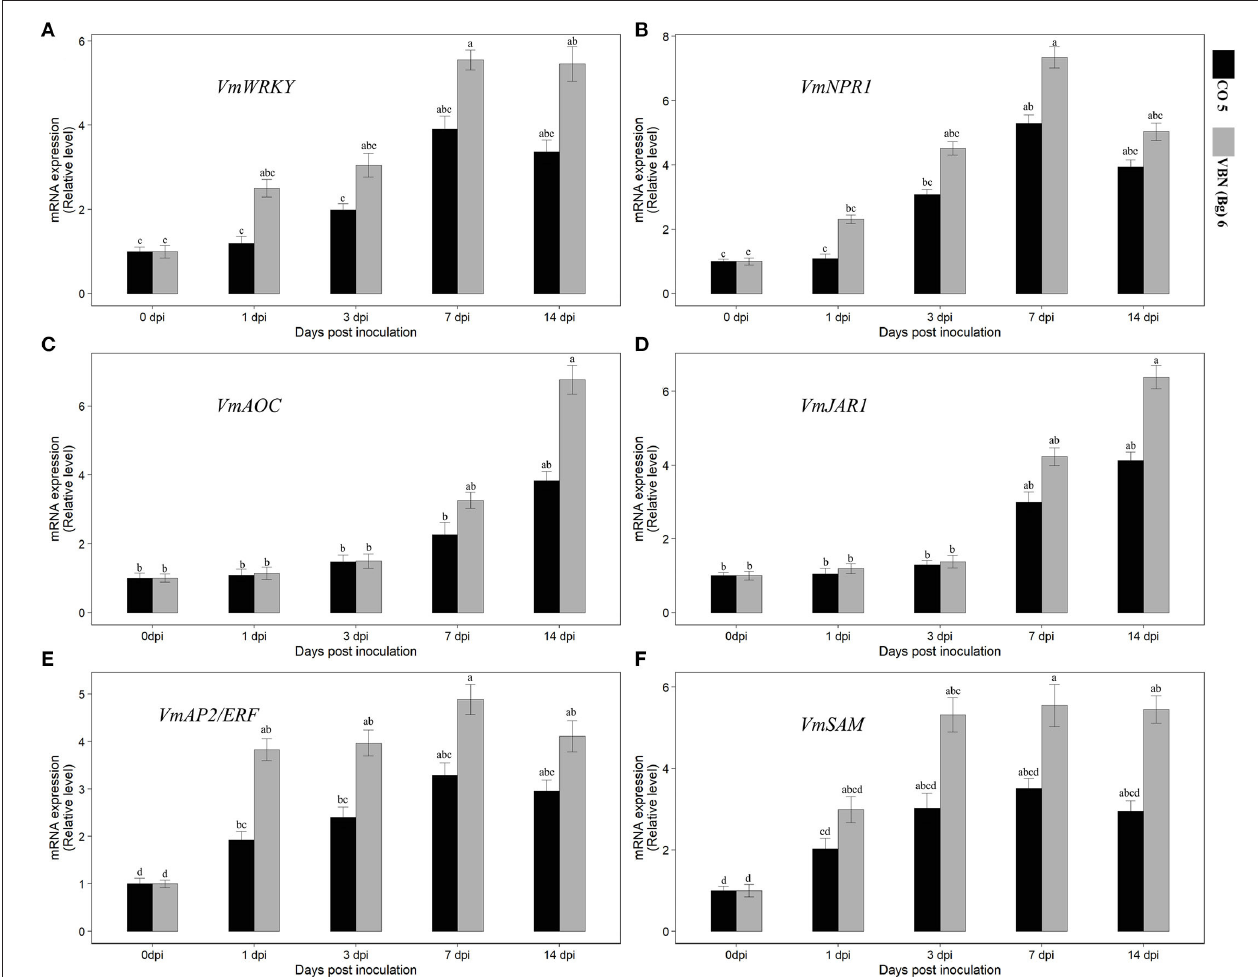
FIGURE 3 | Effect of urdbean leaf crinkle virus infection on the relative expression level of SA [ VmWRKY and VmNPR1 ] (A,B) , JA [ VmAOC and VmJAR1 ] (C,D) , and ET [ VmAP2/ERF and VmSAM ] (E,F) pathway-related genes in two blackgram cultivars VBN (Bg) 6 and CO 5. Values followed by the same letter are not significantly different ( p ≤ 0.05) according to Duncan’s multiple range test. Bars present means ± SE ( n =